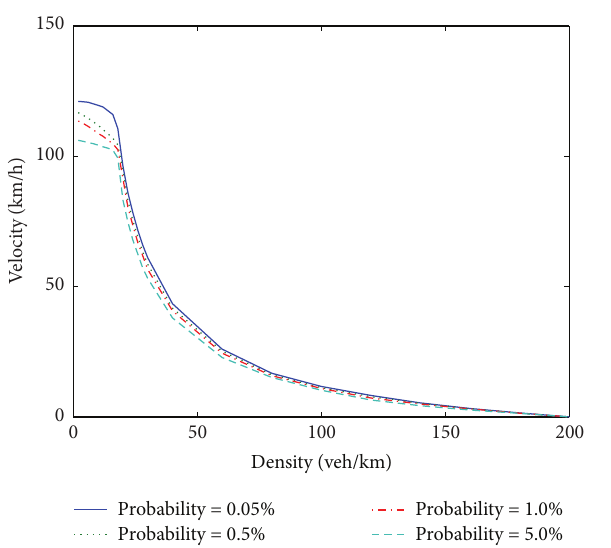
Figure 4: The change of velocity with different probability of phone use.